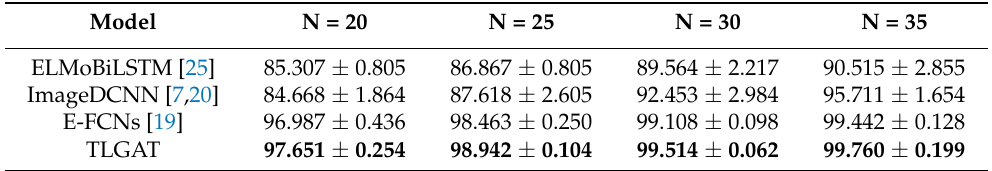
Table 3. The overall F 1 - score ( % ) (mean ± 3 σ ) of ELMoBiLSTM, ImageDCNN, E-FCNs, and TLGAT in the ARUBA dataset.